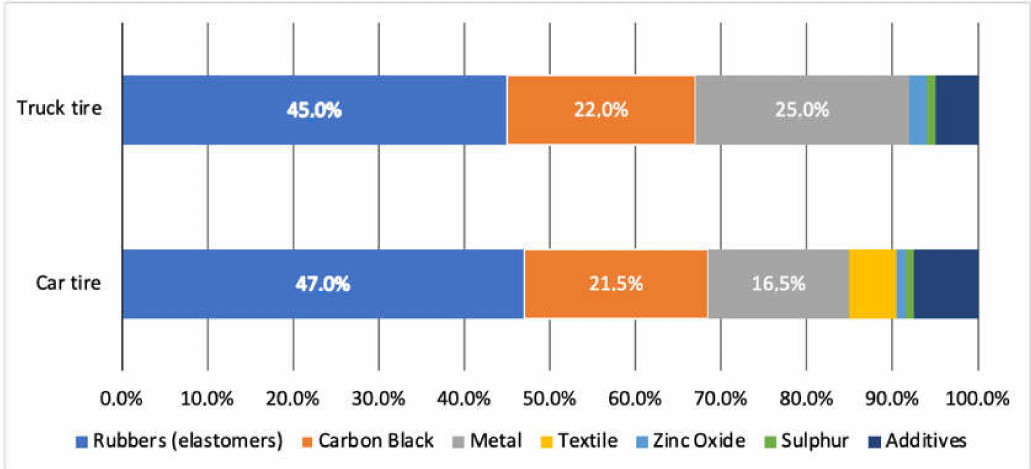
Figure 1. Typical passenger car tire construction (author’s image).